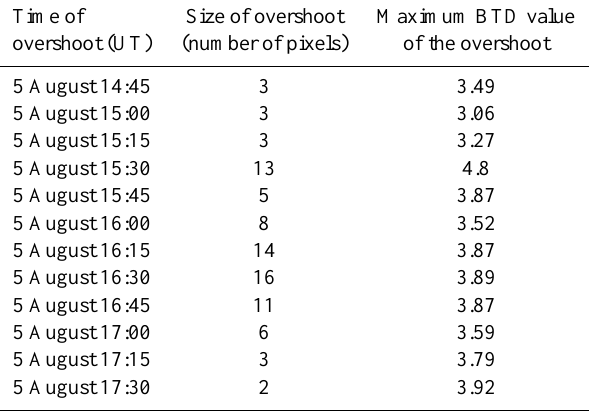
Table 2. Model setting used for the Chad (4 August 2006) and A¨ır (5 August 2006) case simulations. Size, resolution and starting time for each grid are